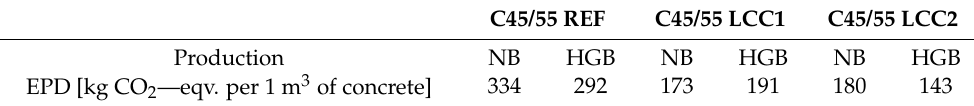
Table 4. EPD calculations for demonstration series in two different concrete